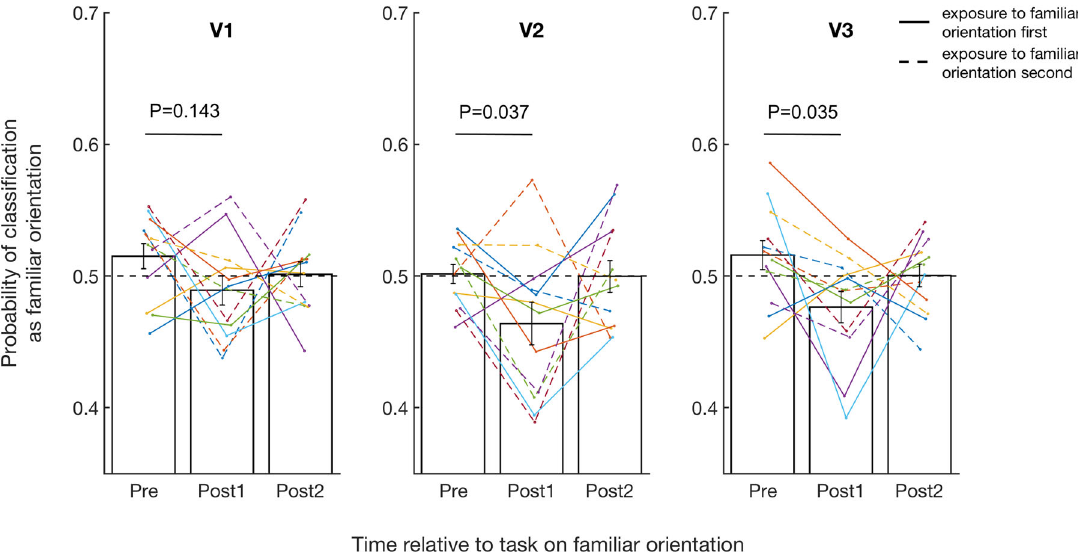
Fig. 3 Probability that neural patterns are classi fi ed as the familiar orientation before and after exposure to the familiar orientation. Brain activity was less likely to be classi fi ed as the familiar orientation across V1 – V3 shortly after exposure to the familiar orientation, indicating the presence of awake suppression. “ Pre ” refers to two initial scans before subjects saw any stimuli (5 min/scan; combined into a single “ Pre ” baseline). “ Post1 ” and “ Post2 ” refer to the fi rst and the second post-task scans immediately after exposure to the familiar orientation. The solid and dashed lines represent subjects who were exposed to the familiar orientation fi rst and second, respectively. The P values in the fi gure refer to the results of paired t tests between pre and post1. Error bars indicate s.e.m. N =